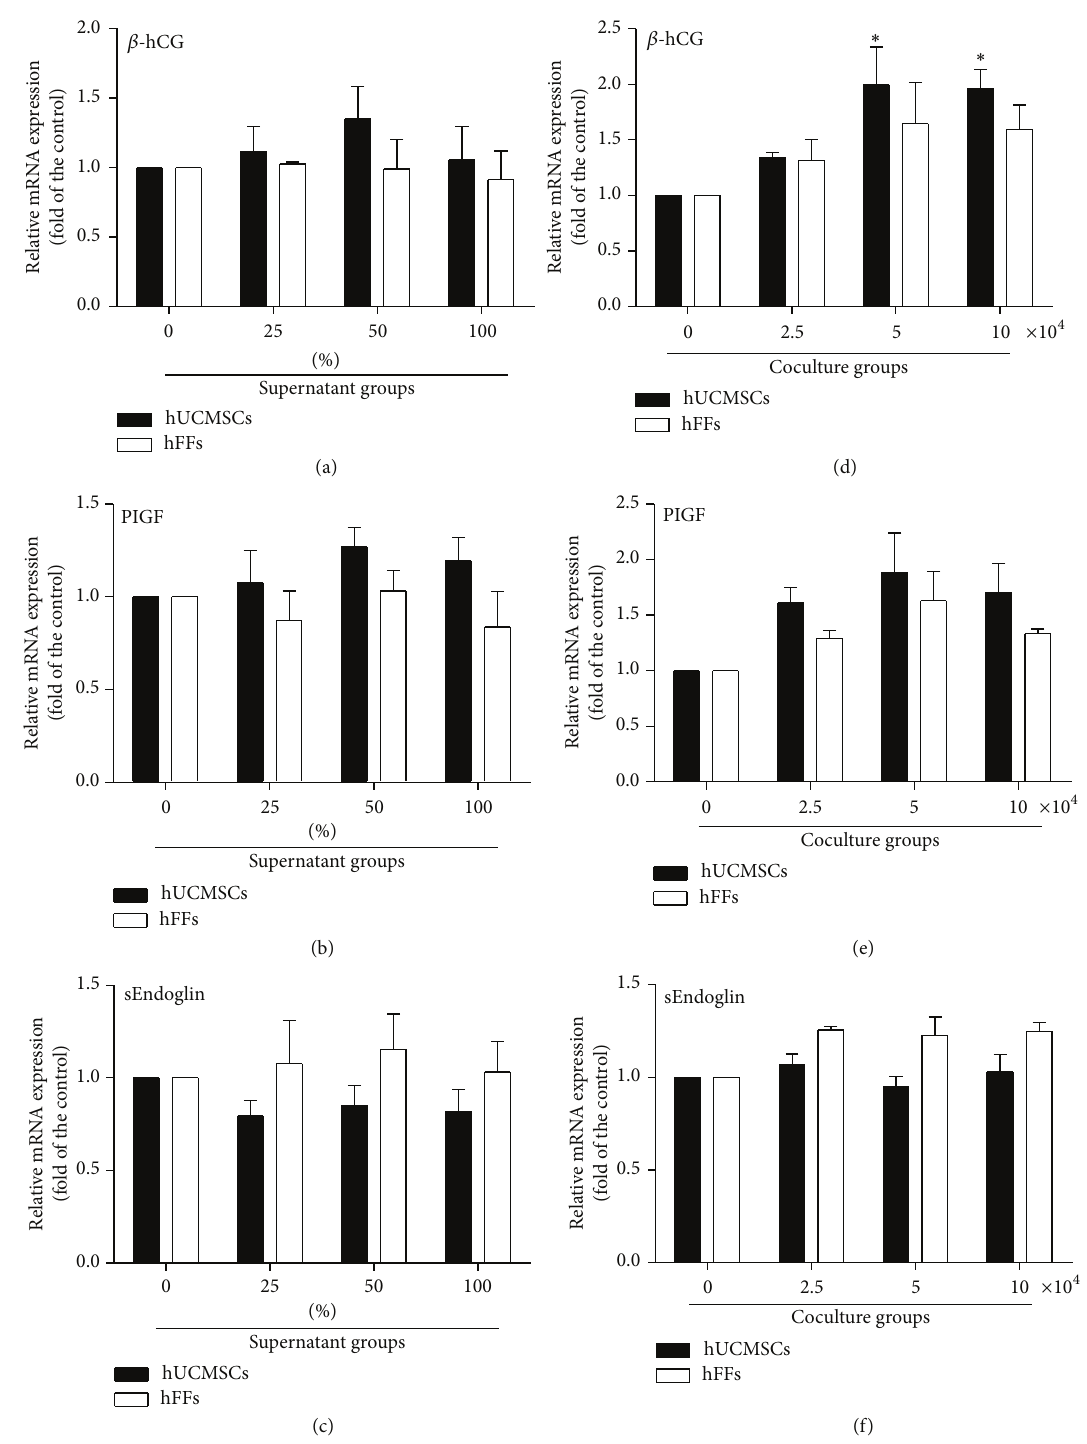
Figure 8: Effect of hUCMSCs and hFFs on cytokine secretion of HTR-8/SVneo cells as detected by real-time PCR. (a–c) HTR-8/SVneo cells (10 × 10 4 cells/well) were cultured in 0, 25, 50, or 100% hUCMSC or hFF supernatant in medium for 48 hours. (d–f) HTR-8/SVneo cells (10 × 10 4 cells/well) were cocultured with hUCMSCs or hFFs at a concentration of 0, 2.5, 5, or 10 × 10 4 cells/well in 6-well Transwell plates for 48 hours. Cytokine amounts were assessed in the resulting culture medium. ∗ represents significant differences versus control ( 𝑃 < 0.05 ); ∗∗ represents very significant differences versus control ( 𝑃 < 0.01 ); # represents significant differences between hUCMSCs and hFFs at an individual dose ( 𝑃 < 0.05